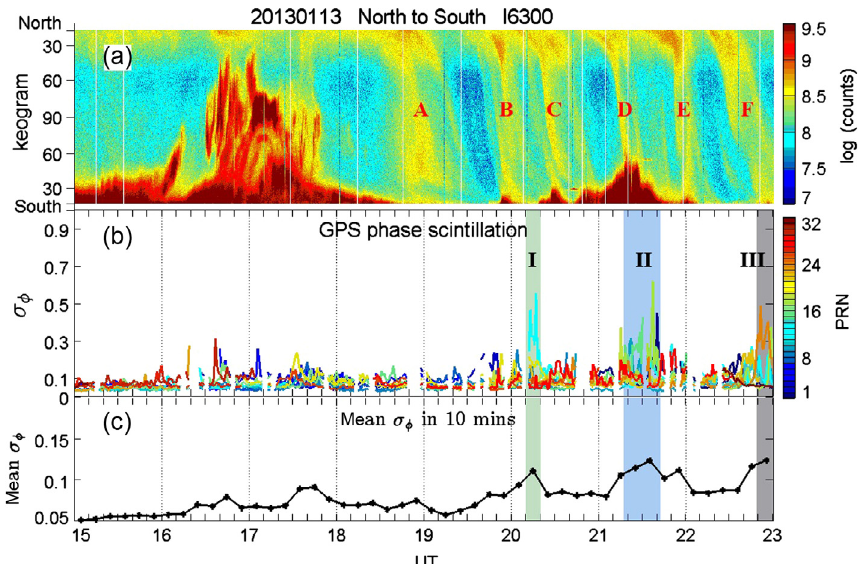
Fig. 1. (a) The keogram scanned along the North-South cross section as a function of scan angle from 15 (cid:2) North to 15 (cid:2) South from the 630.0 nm channel of the all-sky imaging photometer (ASIP) at Ny-A˚ lesund, January 13, 2013, 15–23 UT. Letters A–F mark six polar cap patches as they moved from north to south across the ASIP. The intensity is color coded according to the log (counts) scale on the right. (b) Phase scintillation indices recorded by the GPS scintillation monitor located at Ny-A˚ lesund, measurements from different satellites are color coded on the right. (c) Mean phase scintillations for all satellites averaged over 10 min. Shaded regions I–III denote enhanced scintillation events described in the